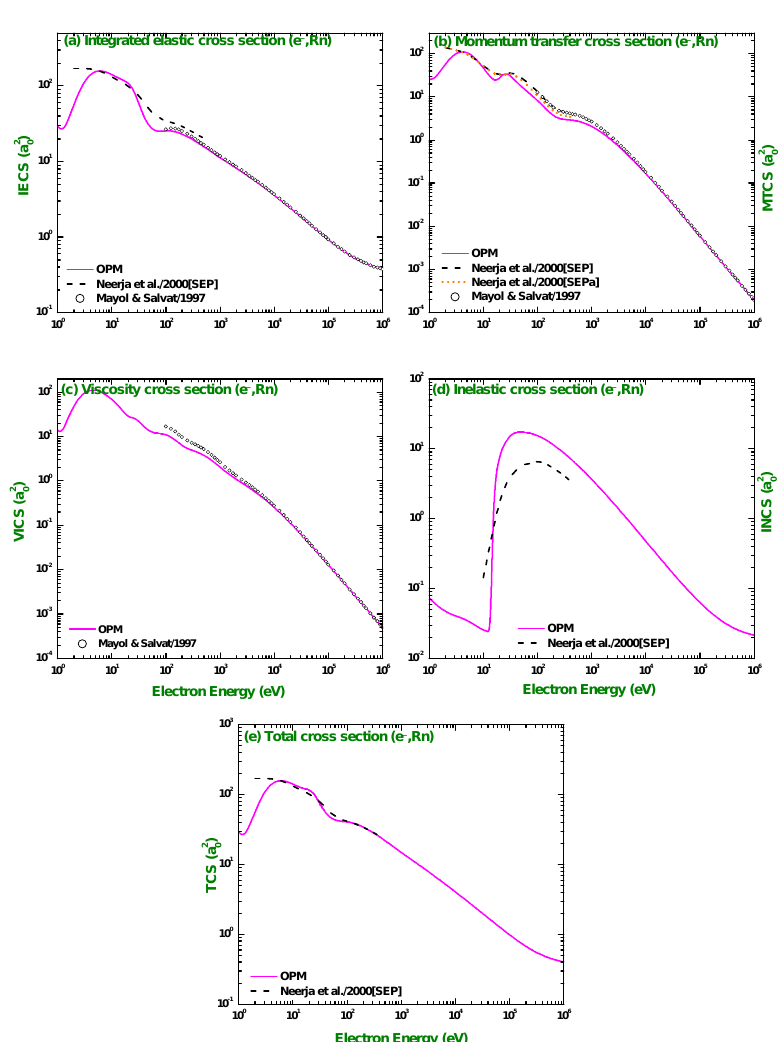
Figure 18. Energy dependence of the ( a ) integrated elastic, ( b ) momentum-transfer, ( c ) viscosity, ( d ) inelastic and ( e ) total cross sections for electron impact scattering from neutral radon atoms. Presented are the theoretical calculations — for the present results, − − − for Neerja et al. [19], .... for Neerja et al. [19] and ◦ ◦ ◦ for Mayol and Salvat. SEP and SEPa, respectively, denote the static-exchange-polarization potentials and SEP with absorption